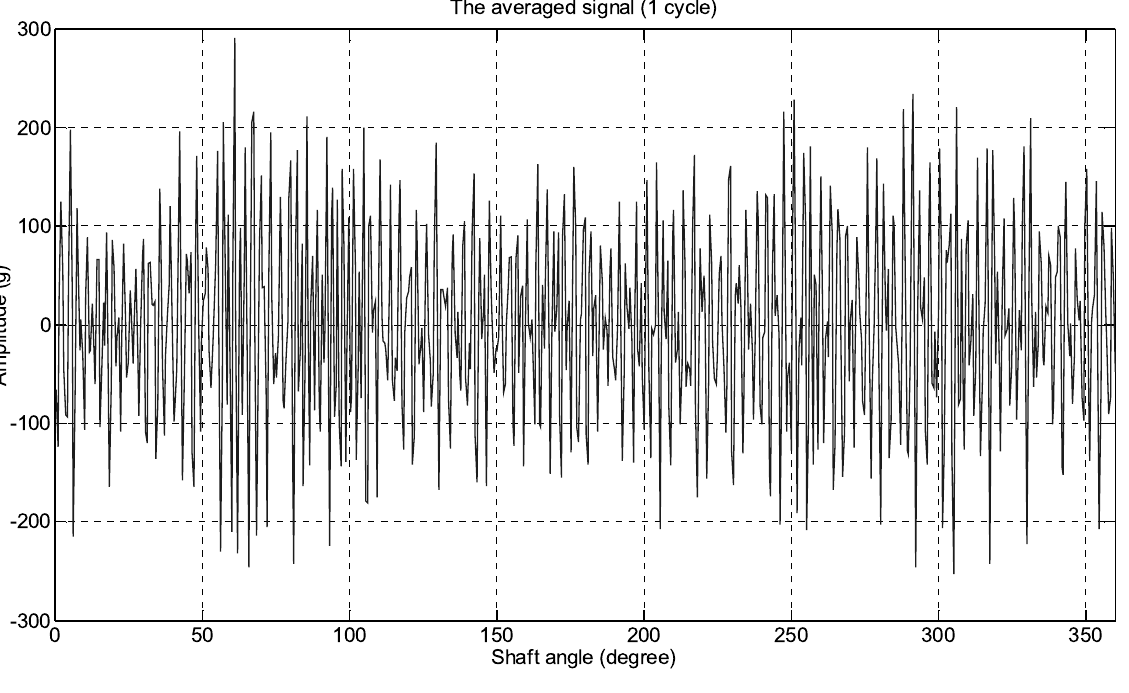
Fig. 10. Time averaged vibration signal for no-fault gear.